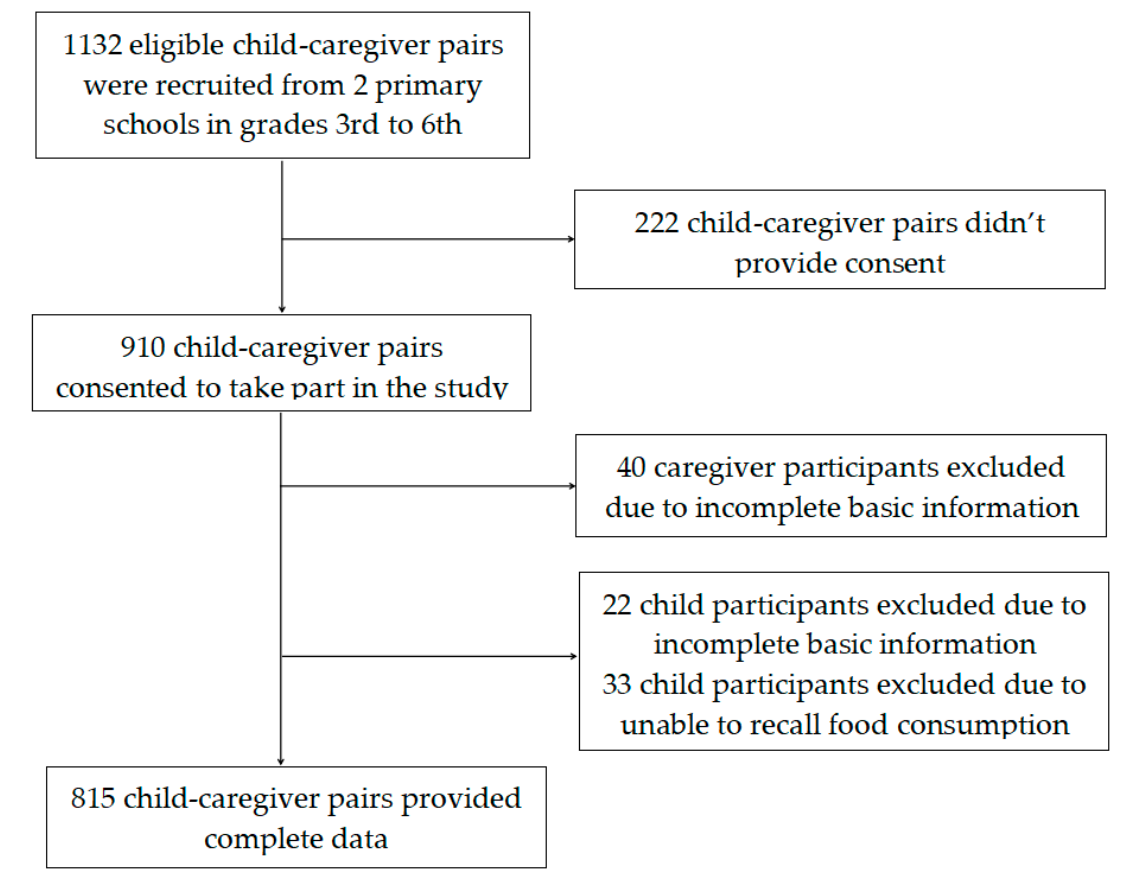
Figure 1. Flow diagram of subject recruitment.